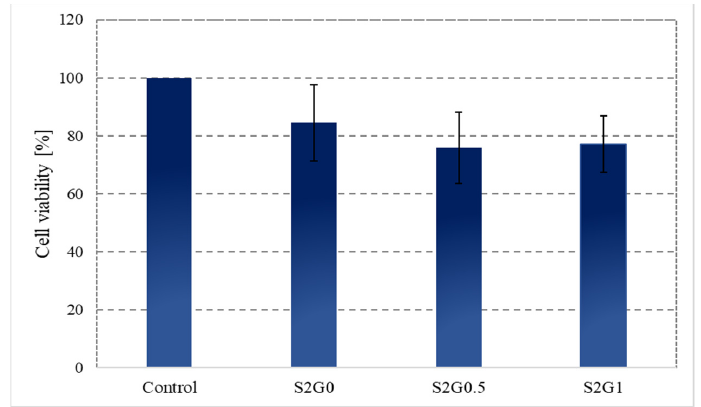
Figure 8. Fibroblasts cell viability seeded onto hydrogel discs ( n =